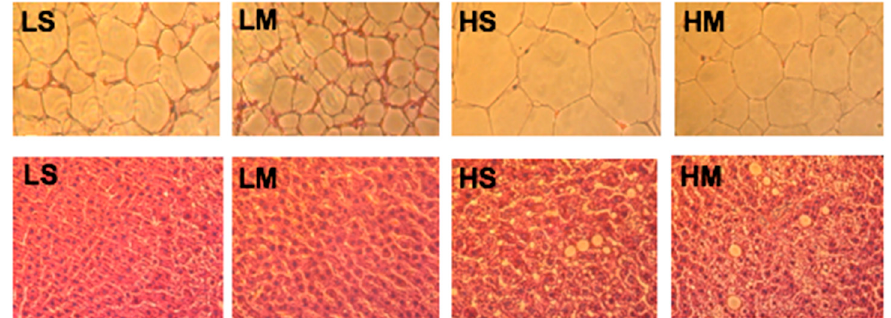
Figure 5. Reproductive white adipose tissues (upper row) and liver tissues (lower row) of type 2 diabetes mellitus rats fed the different diets for 8 weeks, shown with hematoxylin and eosin staining (10 × ). LS, diet contained 16% soybean oil; LM, diet contained 8% soybean oil and 8% medium-chain triglyceride oil; HS, diet contained 58% soybean oil; HM, diet contained 29% soybean oil and 29% medium-chain triglyceride